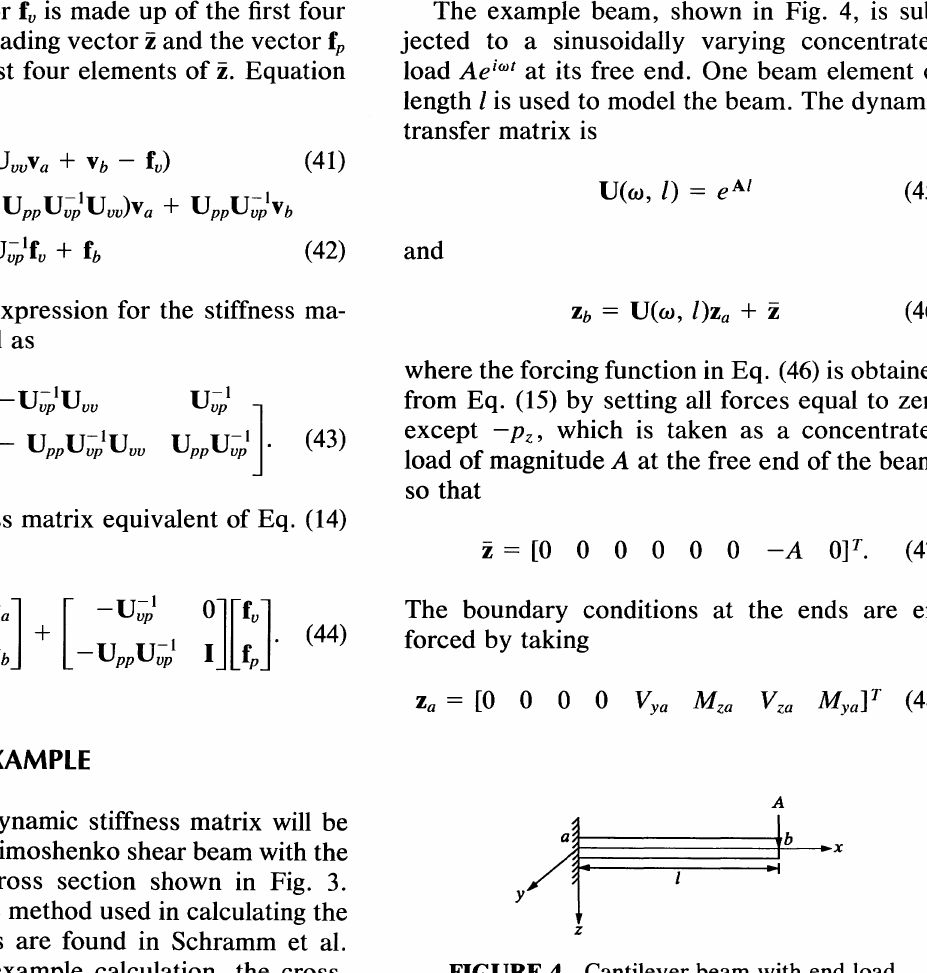
FIGURE 4 Cantilever beam with end